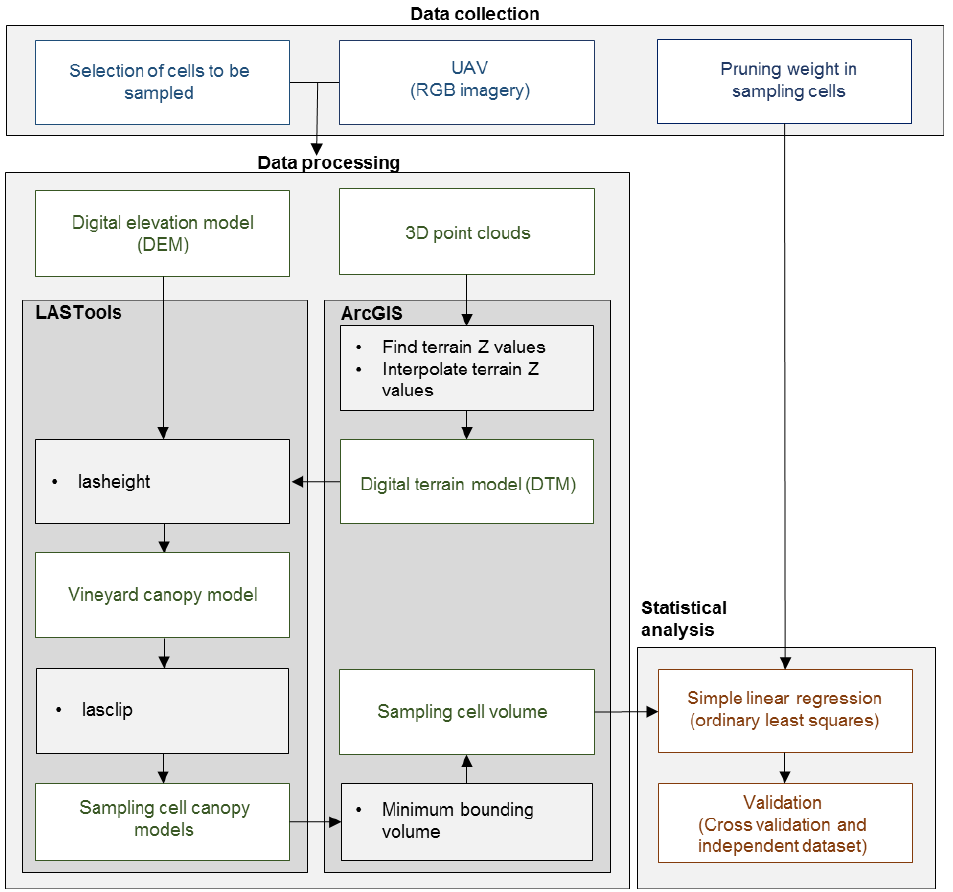
Figure 1. Methodology.